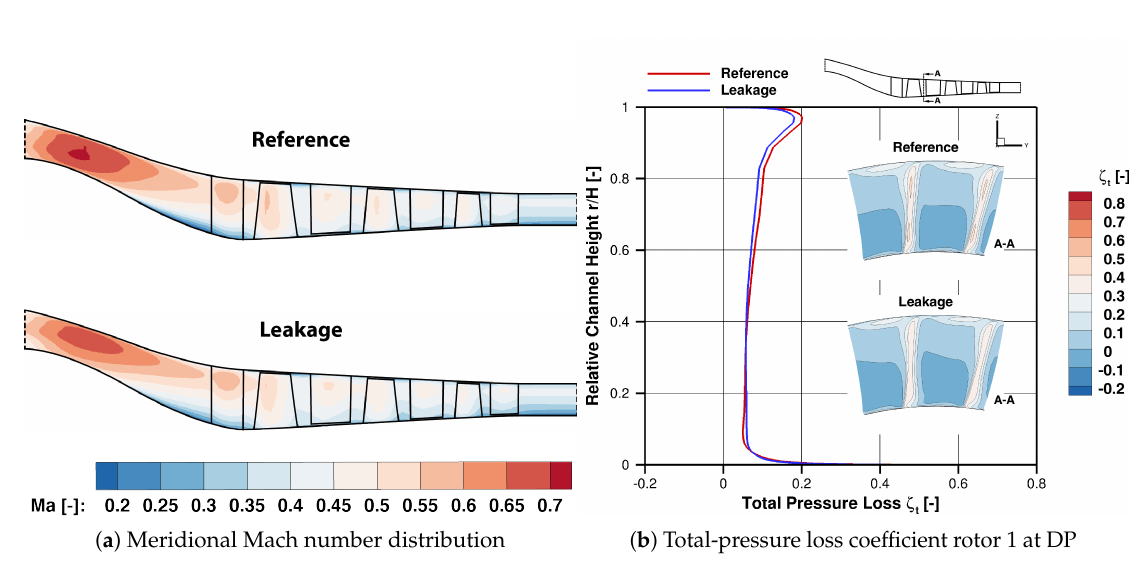
Figure 11. Effect of leakage mass flow on the IGV.